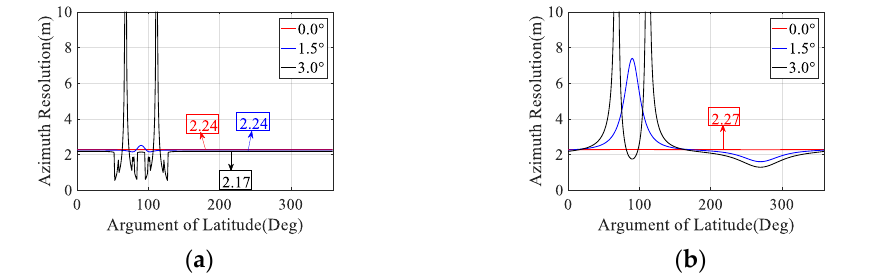
Figure 9. Azimuth resolution along the orbit. ( a ) With the consideration of variations of the RLS; ( b ) without the consideration of variations of the RLS.